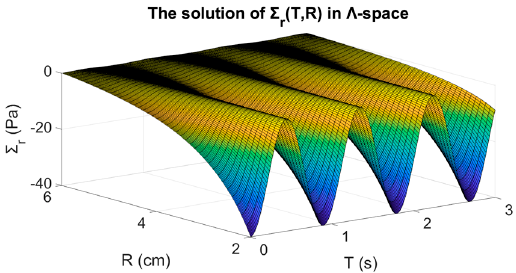
Figure 2. The ventricular cylinder's radial stress Σ -(T,R).